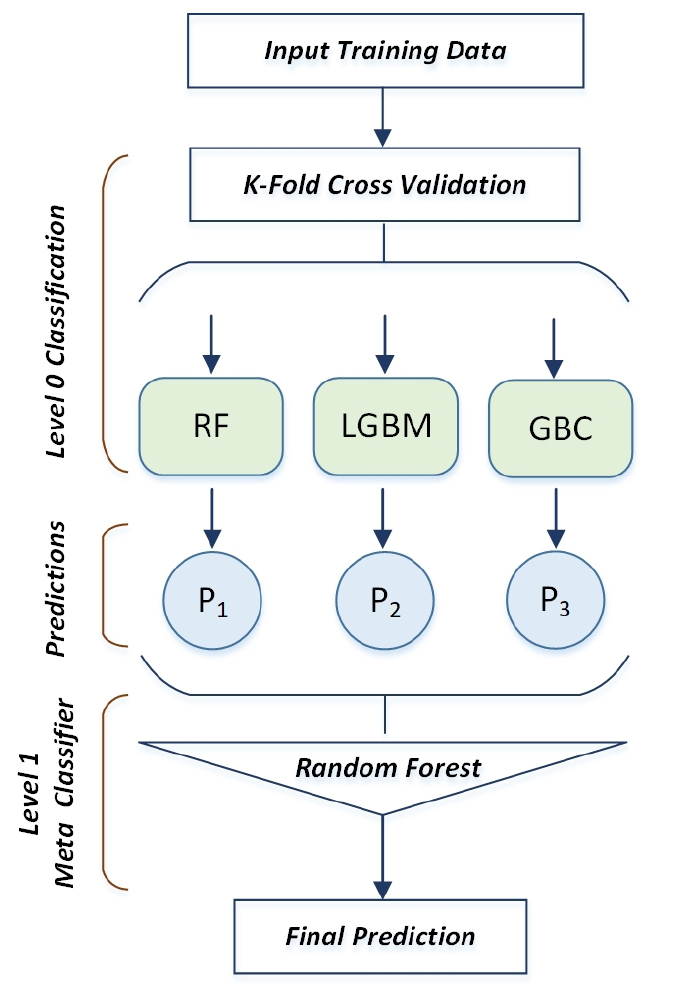
Figure 3. Stacking ensemble classification model